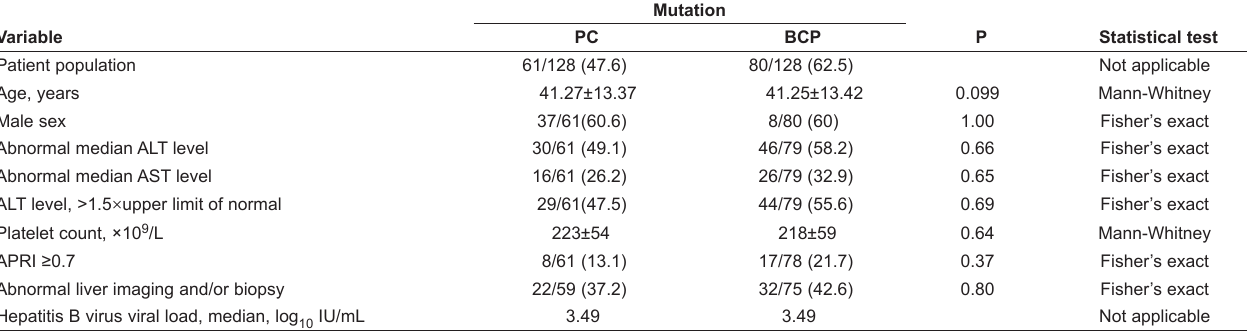
Demographics, laboratory abnormalities and any abnormal liver findings according to imaging or biopsy versus precore (PC)/basal core promoter (BCP)